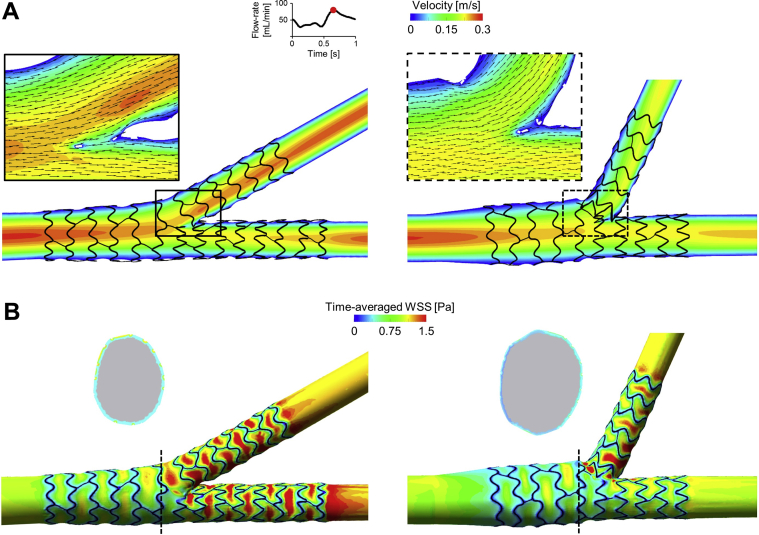
Computational fluid dynamics results of the stented silicone phantoms with vessel sizes of 3.5/2.6/2.6 mm and angle of 30 degrees (left), and vessel sizes of 3.5/2.9/2.2 mm and angle of 70 degrees (right). (A) Velocity contours in the middle plane at peak flow rate. The panels show a magnified image of the velocity field with in-plane velocity vectors at the bifurcation region. (B) Contour maps of time-averaged wall shear stress (WSS). A cross-sectional view at the proximal main branch with the lumen border coloured with the time-averaged WSS is also displayed for each case.